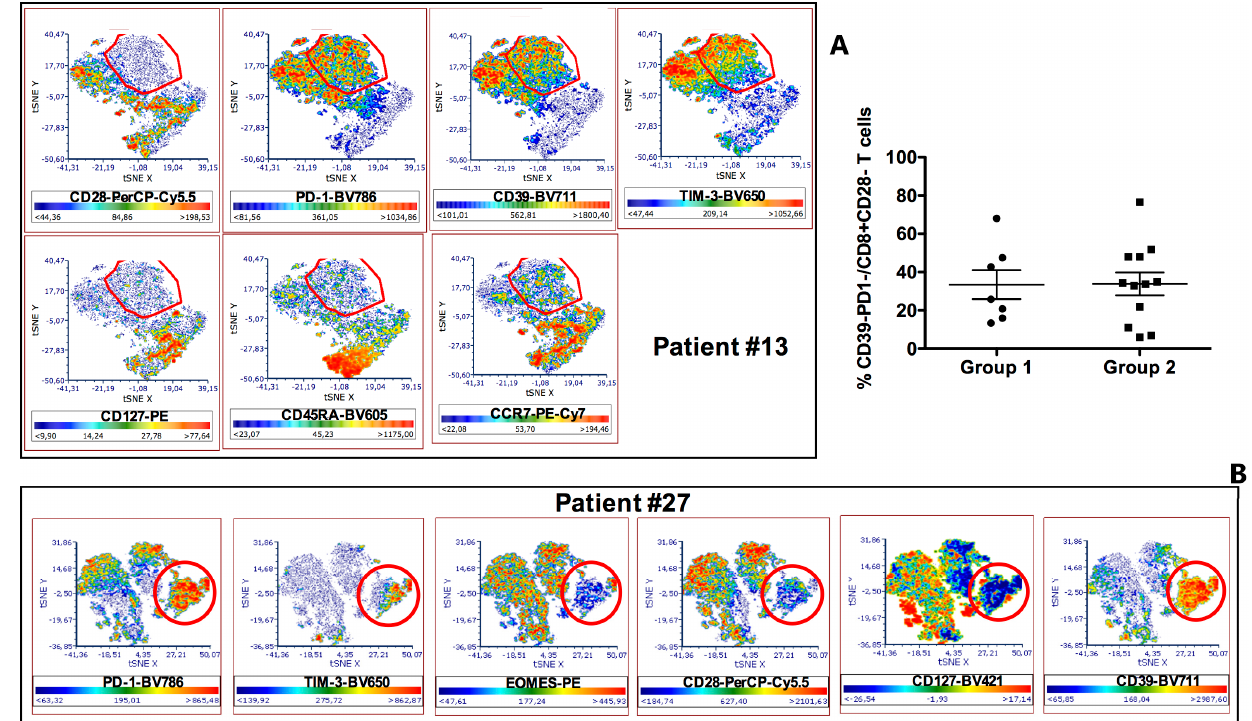
Figure 3. Multiparametric phenotypic characterization of tumor infiltrating CD8+ T cells from HNSCC patients. ( A ): tSNE algorithm was applied to the analysis of tumor infiltrating CD8+ T cells from patient #13. A red circle identifies a map area where cell clusters, negative for CD28, CD127, CD45RA and CCR7 expression and highly positive for PD-1, CD39 and TIM-3 expression, segregate. The colorimetric scale of expression is shown below each graph (blue clusters indicate absent expression, red clusters represent high expression). ( B ): t-SNE algorithm was applied to the analysis of tumor infiltrating CD8+ T cells from patient #27. A red circle identifies a map area where cell clusters, negative for CD28 and CD127 expression, highly positive for PD-1 and CD39 expression, and partly positive for TIM-3 and EOMES expression, segregate. The colorimetric scale of expression is shown below each graph (blue clusters indicate absent expression, red clusters represent high expression). ( C ): Frequencies of CD39-PD-1- T cells among tumor infiltrating CD8+CD28 − T lymphocytes in Group 1 and 2 patients.